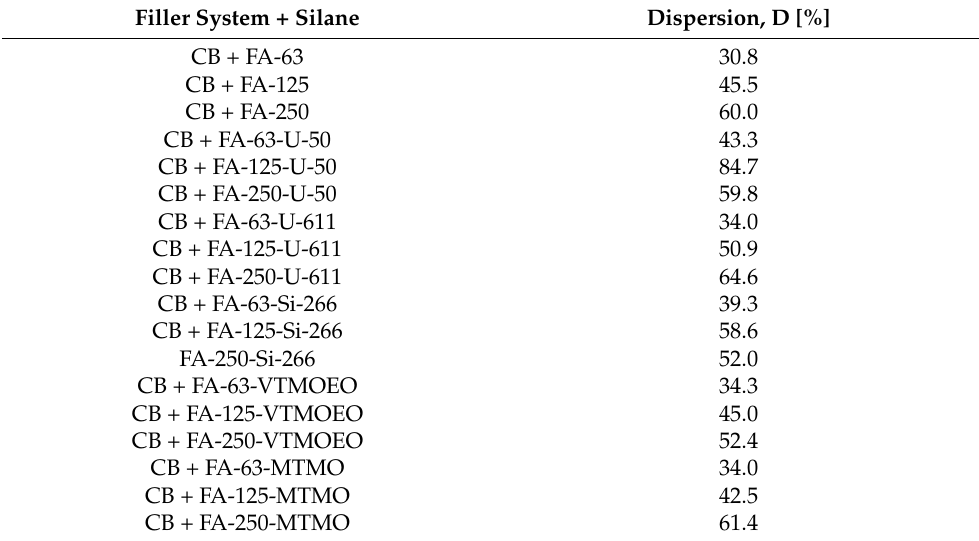
Table 3. Influence of silanization on the filler dispersion of rubber vulcanizates containing 30 phr of N 220 and 20 phr of the fractionated fly ash.